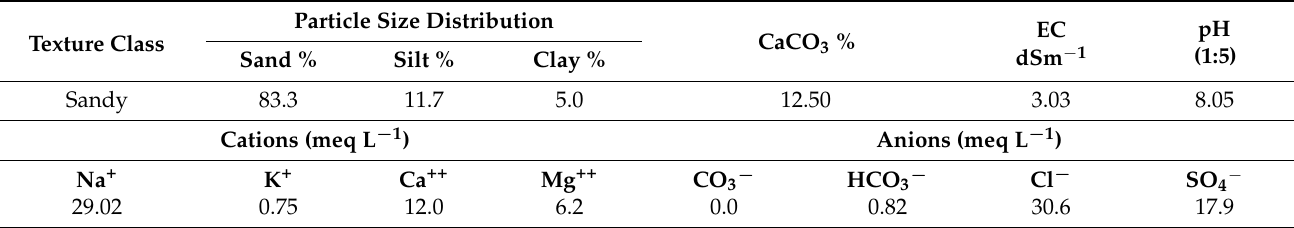
Table 1. Physical and chemical characteristics of the experimental soil site.